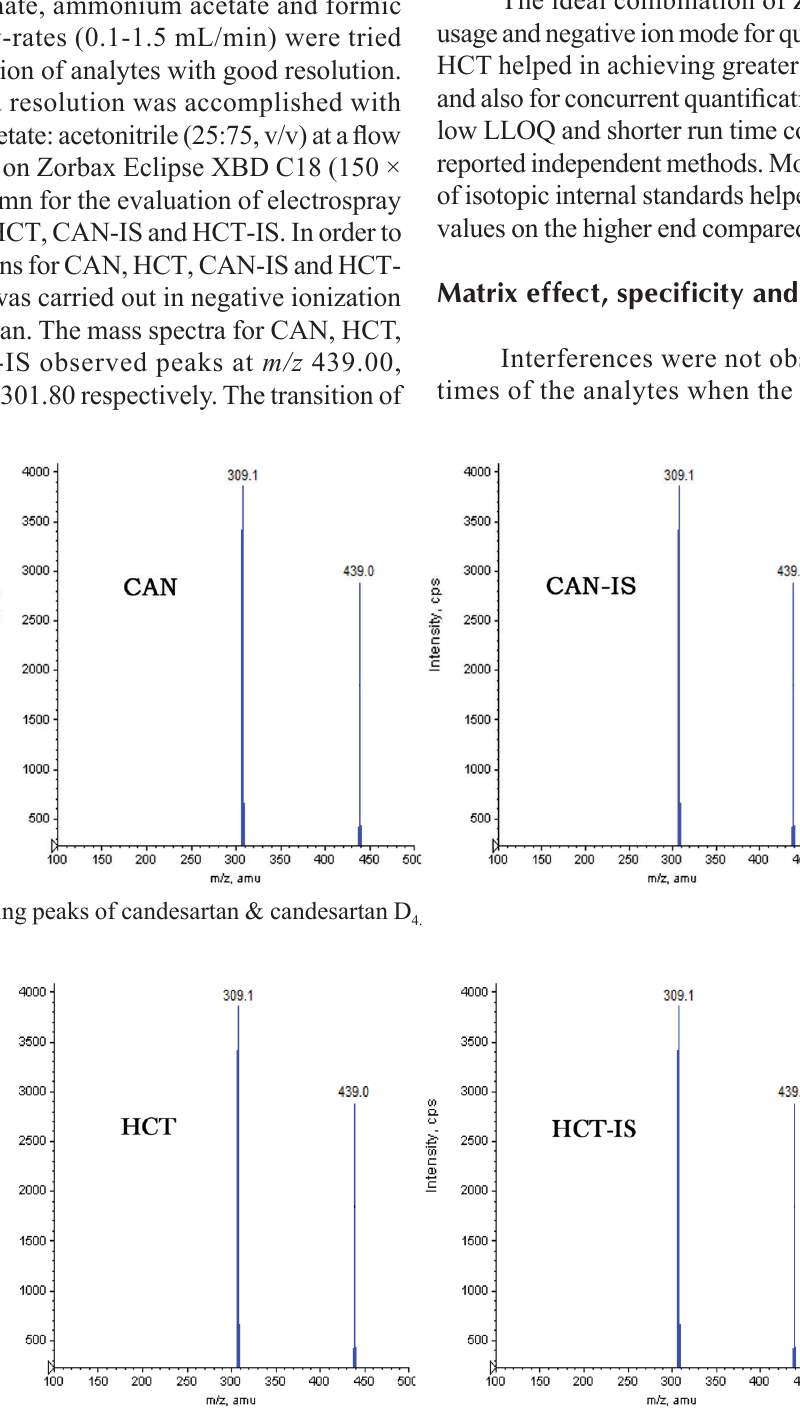
FIGURE 2 - Mass tuning peaks of hydrochlorothiazide & hydrochlorothiazide 13 C